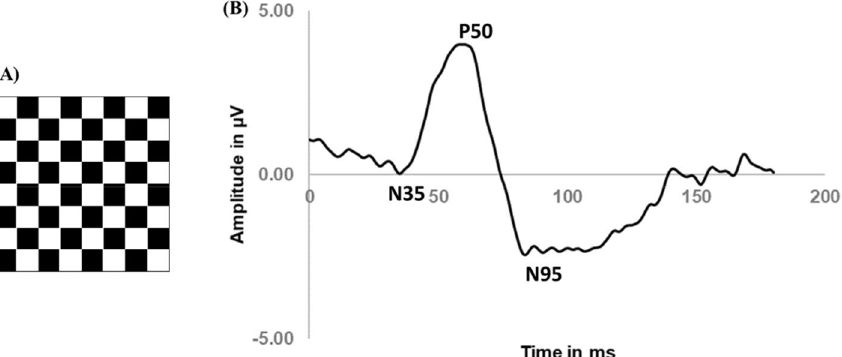
Figure 8. ( A ) Stimulus used for recording ganglion cell electrical activity with PERG methodology. The black and white checks alternate from black-to-white and white-to-black at a regular frequency, with a nearly 100% luminance contrast between checks. ( B ) Typical PERG wave response (example from one of the